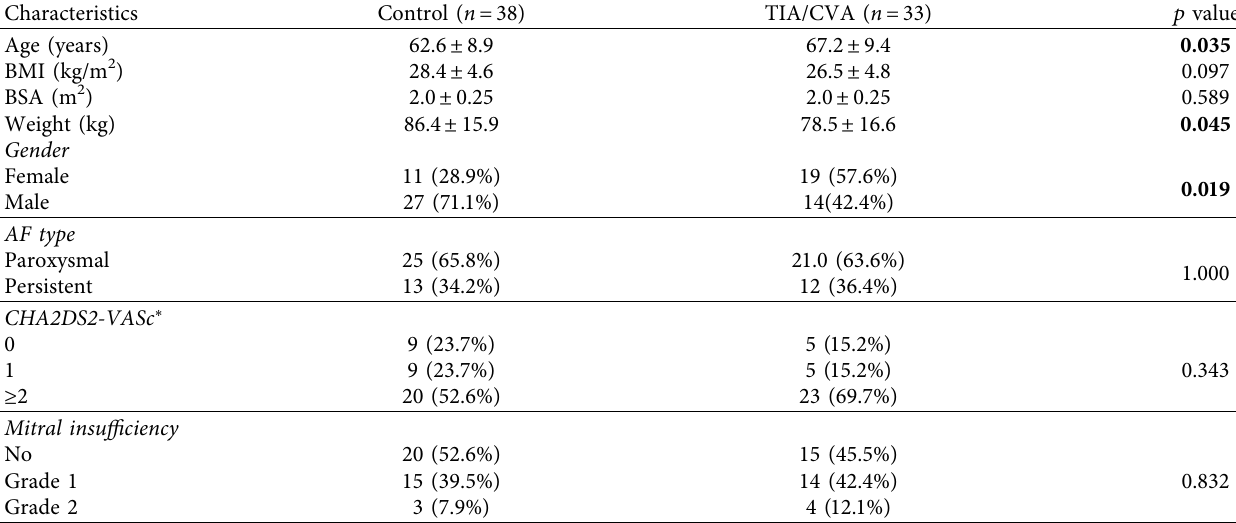
Table 1: Clinical features of patients with and without a history of TIA/CVA